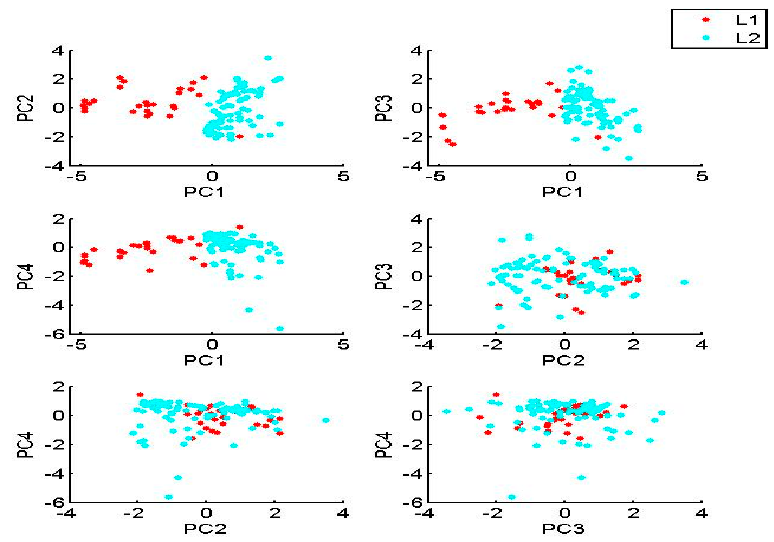
Figure 4. Bivariate plots between four different principal components (PCs) of Lake Megali Prespa (L1) and Lake Mikri Prespa (L2).